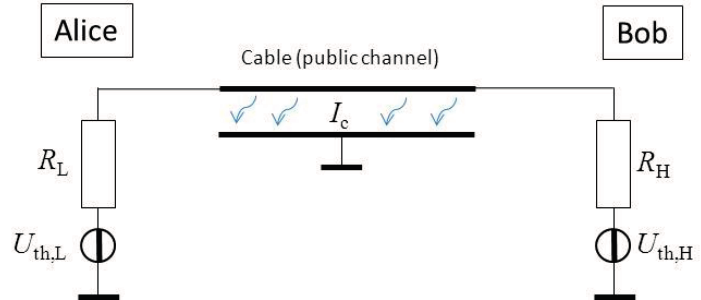
I . The generator voltages c R , and H L